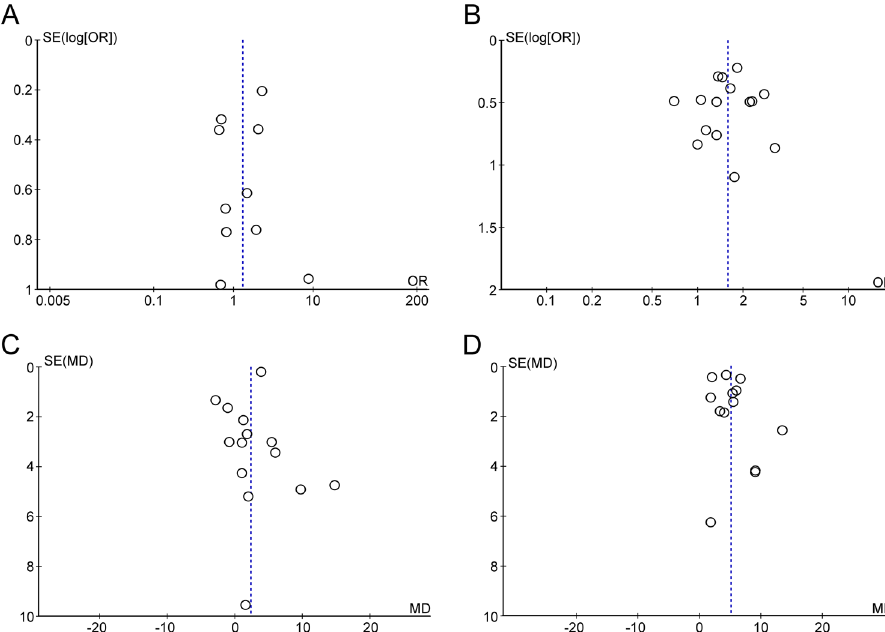
Figure 4. Funnel plots for estimating publication bias in studies on ( A ) Risk of mortality; ( B ) Male gender; ( C ) Age; and ( D ) Circulating D-dimer concentration. SE = standard error, OR = odds ratio, MD = mean